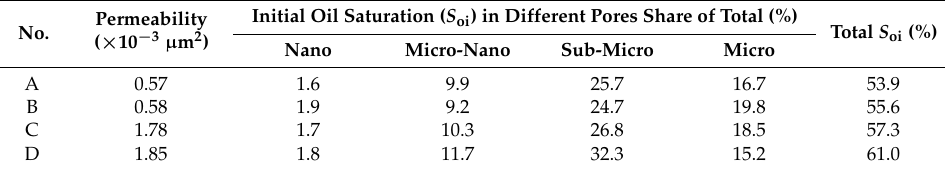
Table 2. Oil saturations for the cores and their different pores saturated with the crude